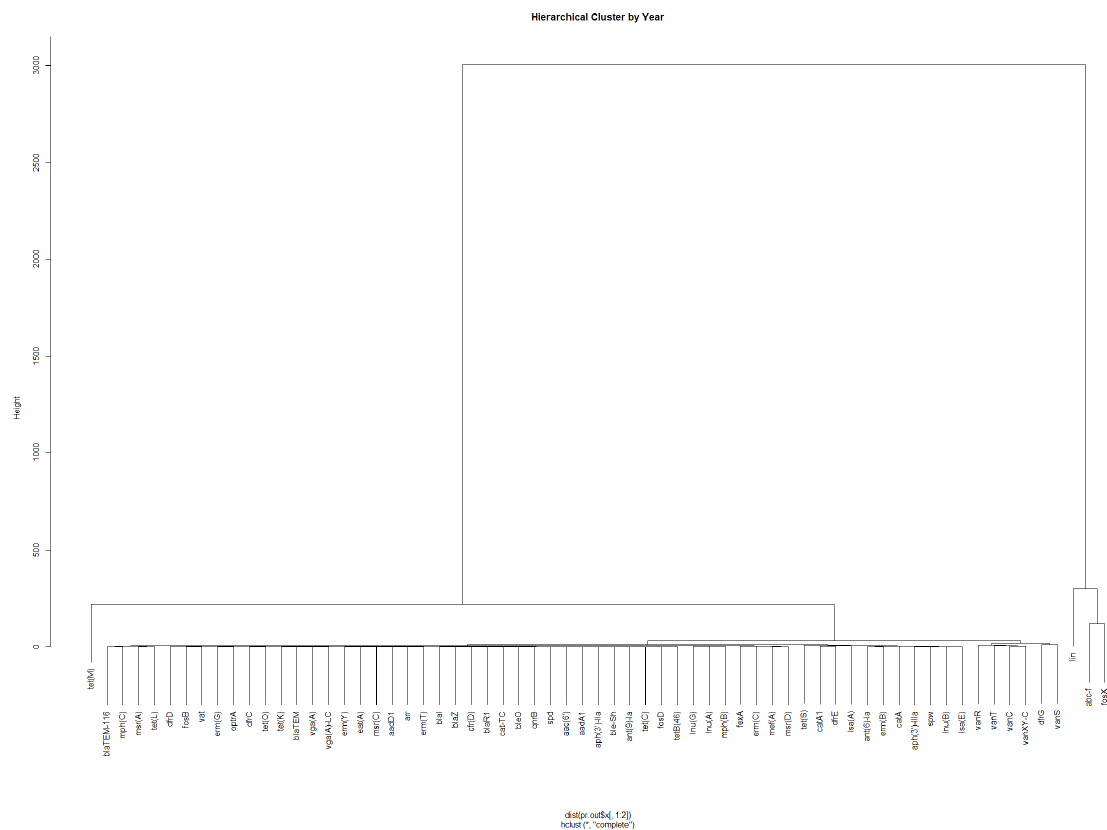
Figure 4. Hierarchical clustering to identify the AMR genes that occurred with similar frequency in L. monocytogenes samples .